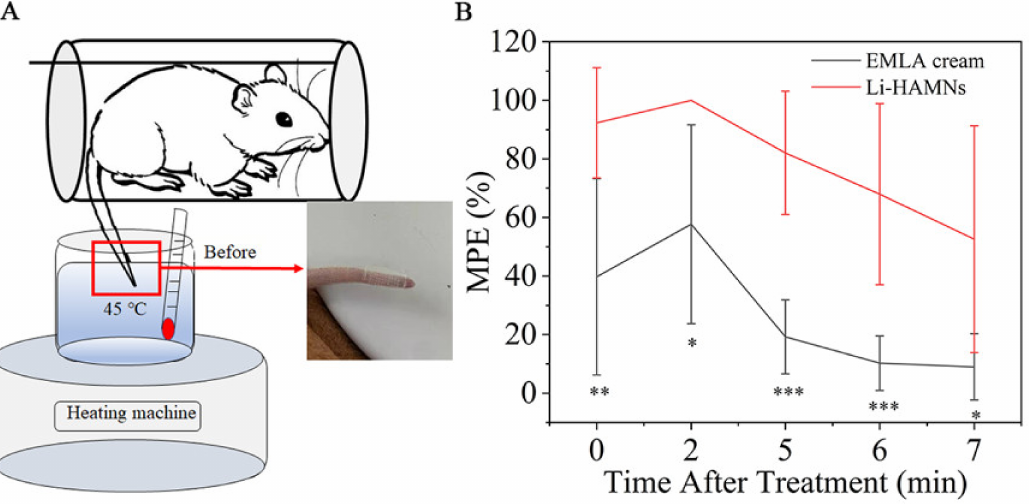
Figure 6. Anesthetic effect (tail-flick experiment) in rats treated with Li-HAMNs. ( A ) Schematic diagram of the water bath method of the tail-flick experiment. ( B ) Quantization of the anesthetic effect over MPE in rats treated with Li-HAMNs and EMLA cream. Data are mean ± SEM ( n = 6). Statistical analyses were carried out by one-way ANOVA plus Tukey post hoc (* p < 0.05, ** p < 0.01, *** p <